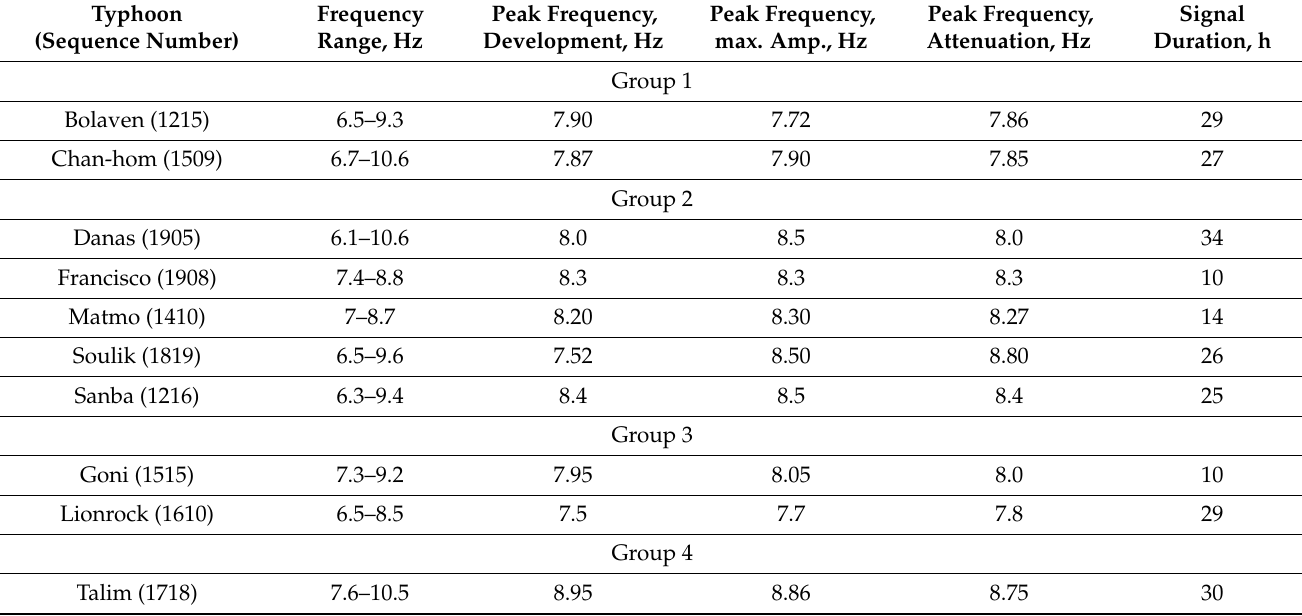
Table 2. Frequency characteristics of the infrasound signal “voice of the